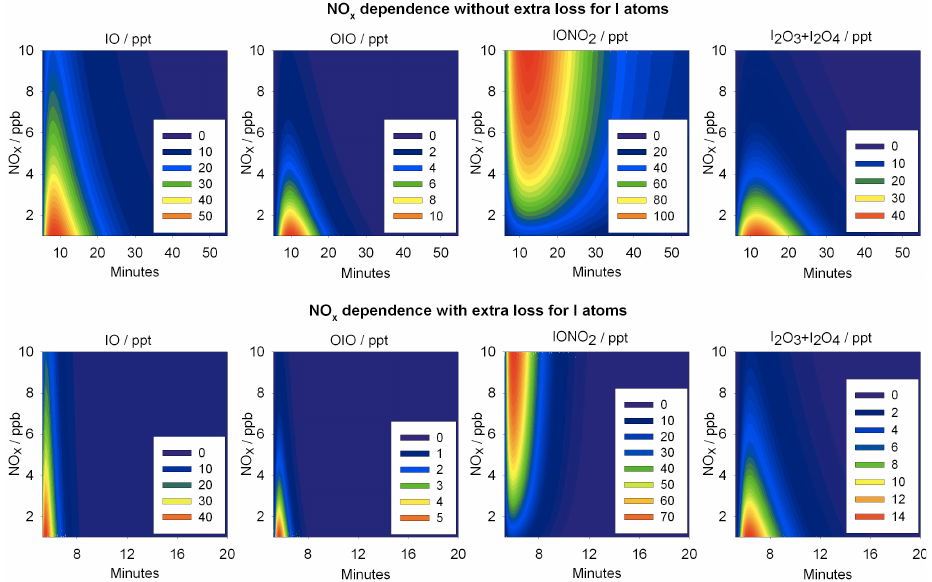
Fig. 6. Dependence of IO, OIO, IONO 2 and I 2 O 3 +I 2 O 4 on NO x mixing ratios for scenarios 4 and 5, which both reproduce the observed I 2 /I ratio. Higher NO x leads to lower levels of iodine oxides, with most of the iodine converted into IONO 2 as the reservoir species. The IO, OIO and IONO 2 are at a height of 1.5m while the I 2 O 3 +I 2 O 4 is at a height of 3.5m. In the model injection of I 2 at a flux of 1.2 × 10 13 moleculecm − 2 takes place after 5min for